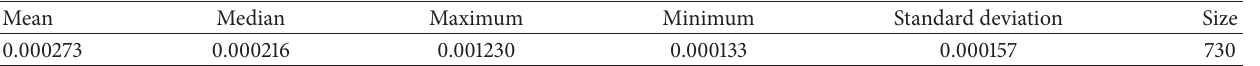
Table 2: The statistics of ̂𝜎 2 𝑚,𝑡 .